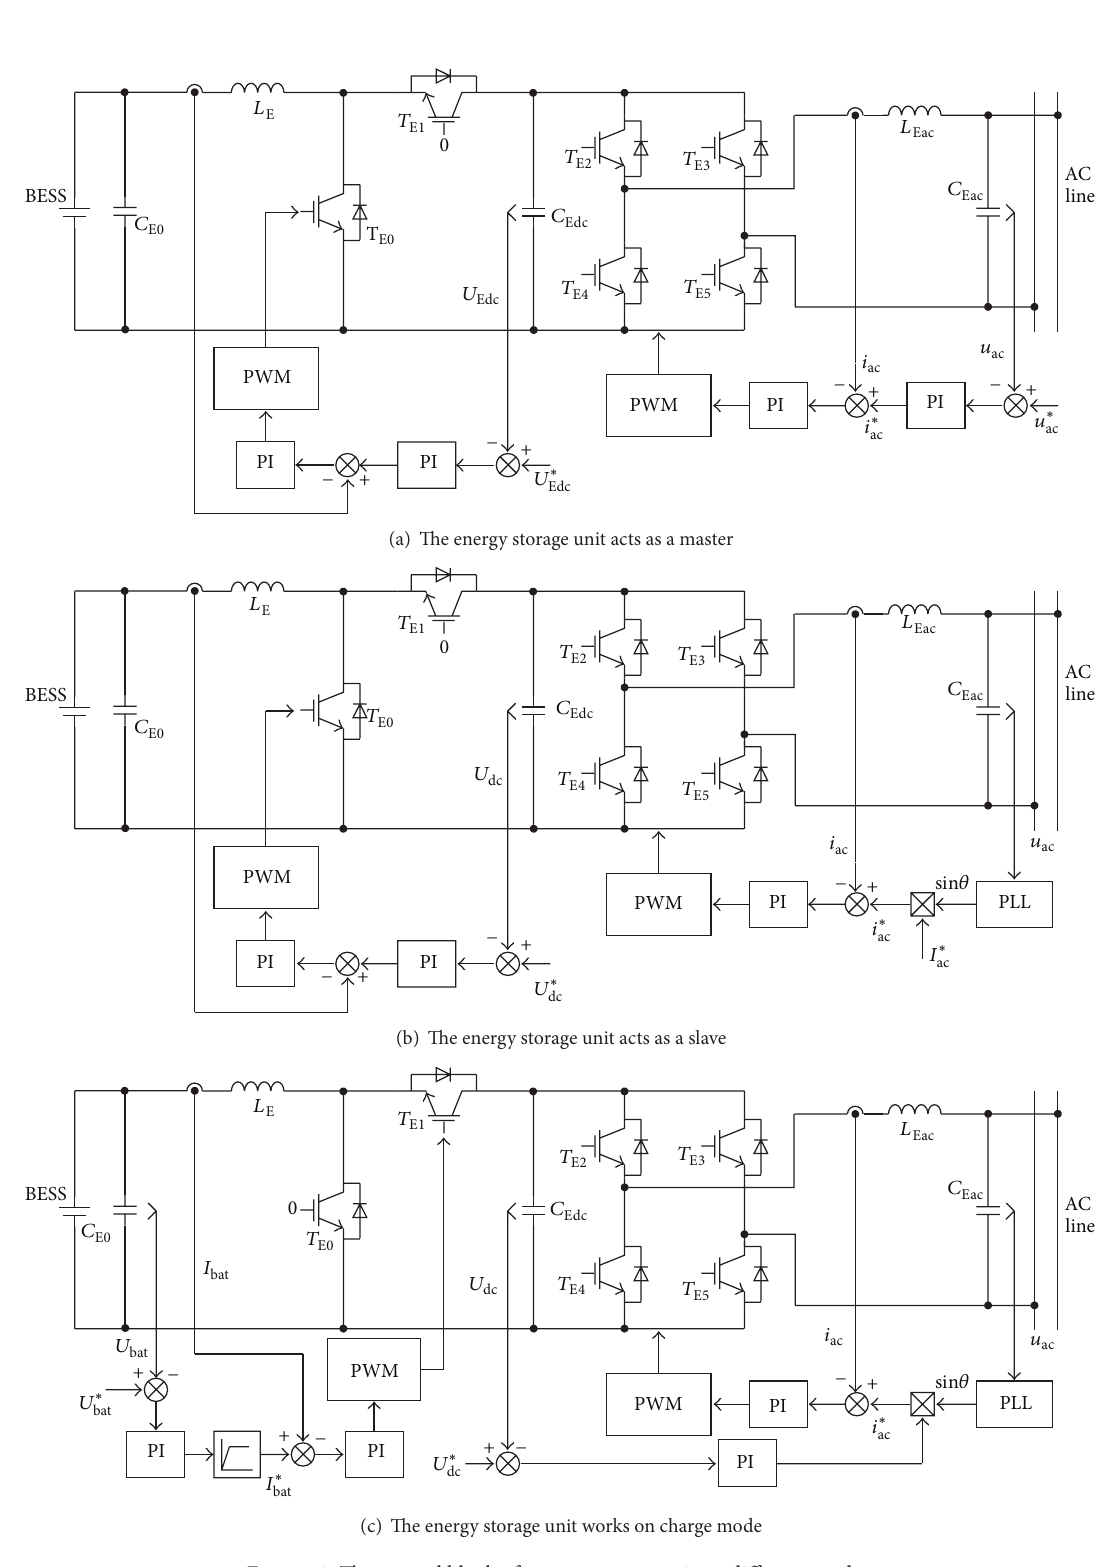
Figure 8: The control block of energy storage unit on different